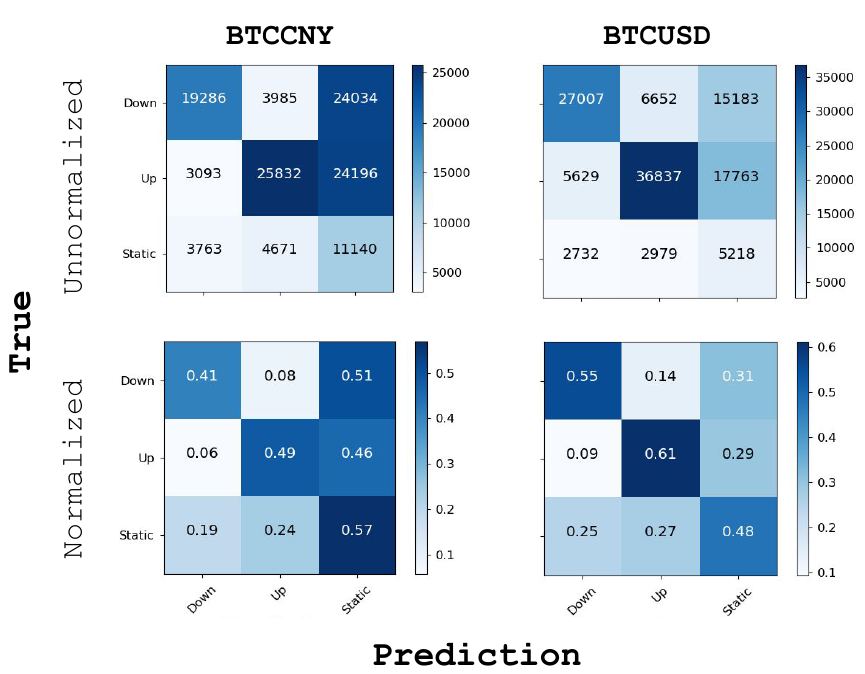
Figure 7. Confusion matrices (LSTM). The x-axis is the prediction, and the y-axis is the true label. Matrices at the top are unnormalized, and the ones at the bottom are normalized. Both unnormalized and normalized matrices are given because there was a crucial class imbalance (Figure 6). As compared to the matrices of Figure 8, the ratio of static prediction became